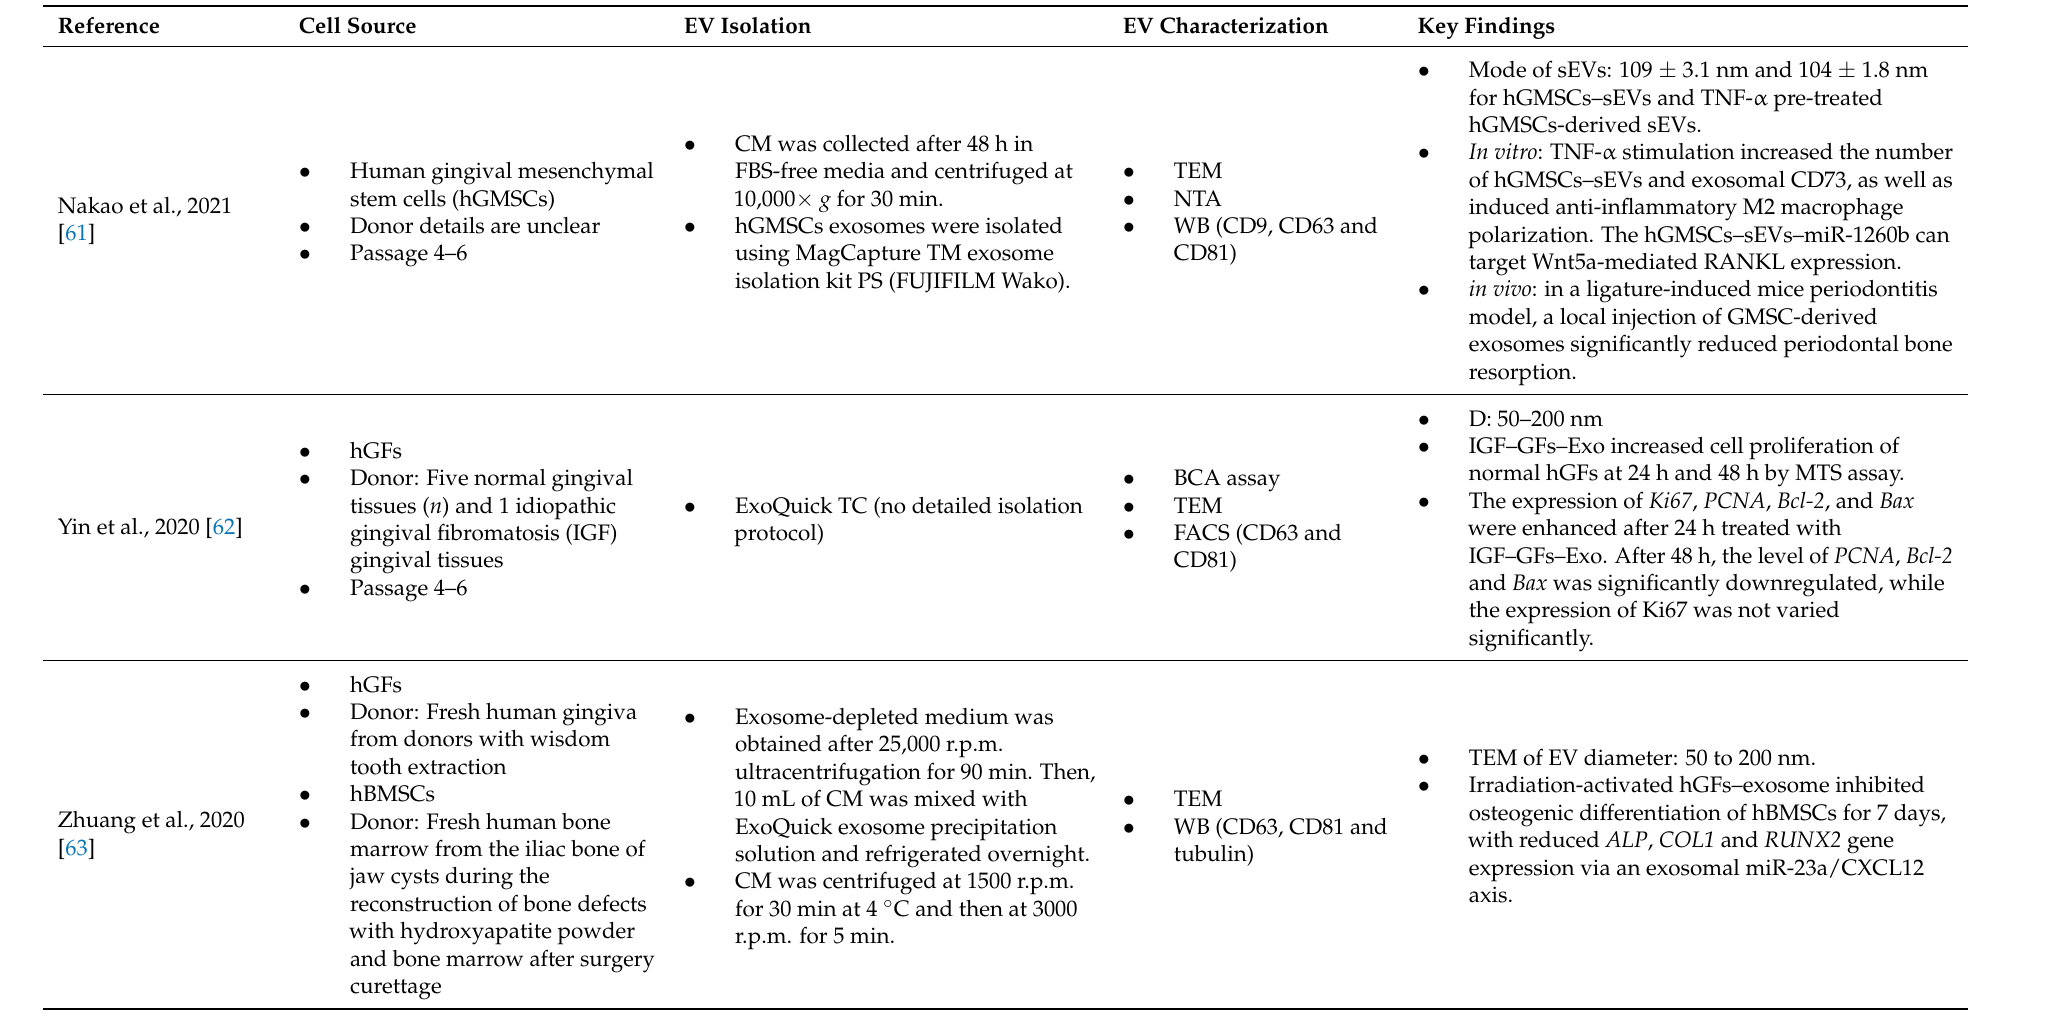
Table 3. The isolation, characterization, and function of EV from hGFs or